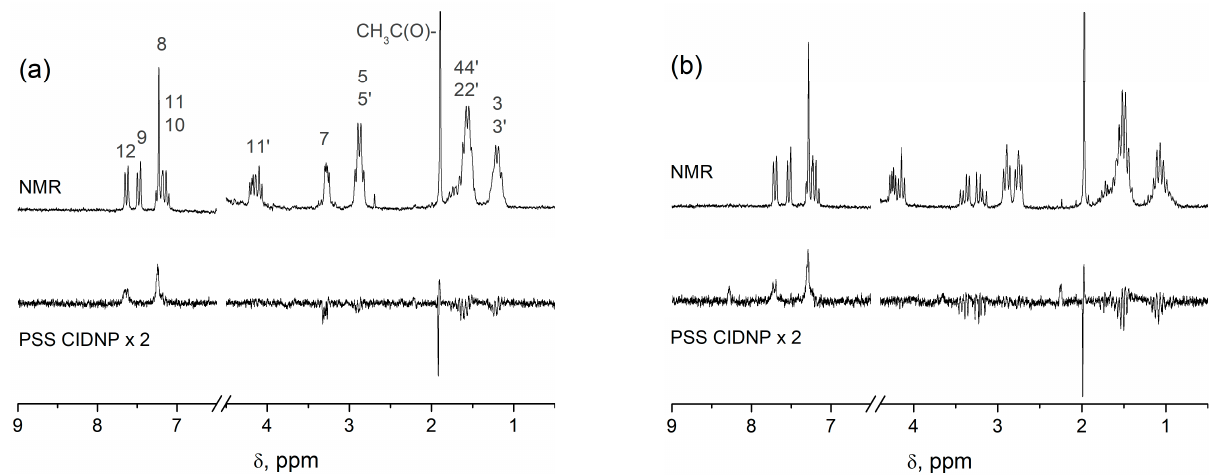
Figure 4. CIDNP effects of 3 mM solutions of I ( a ) and II ( b ) in water-d 2 .